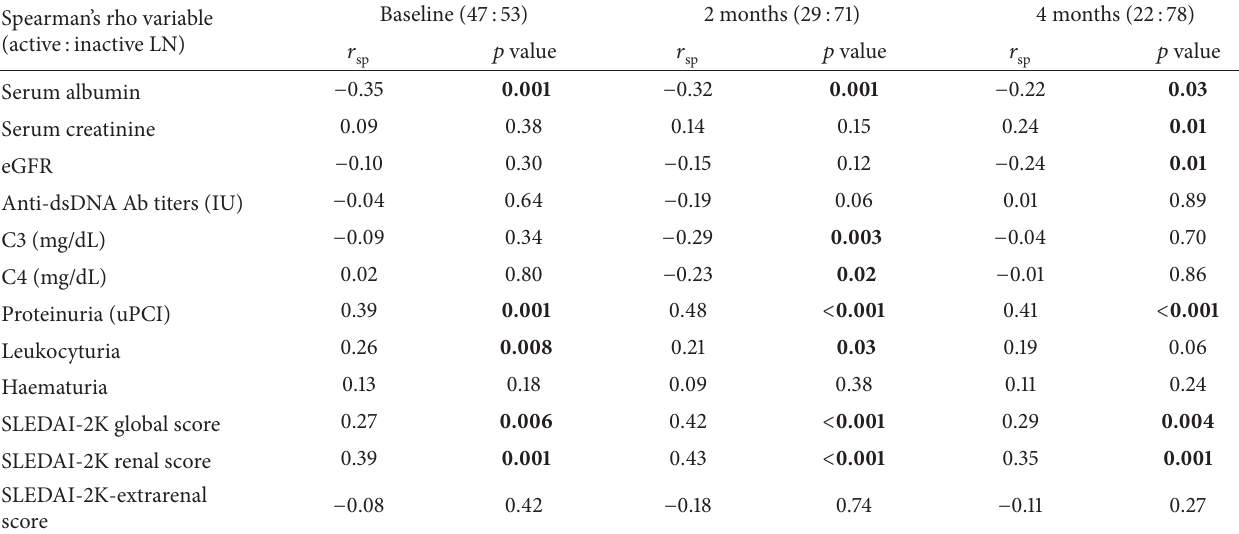
Table 4: Association of uMCP-1 with parameters of LN activity on